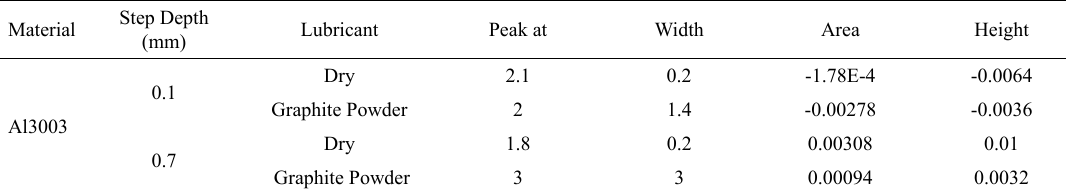
Table 2. Results from regression analysis at 0.1 mm and 0.7 mm step